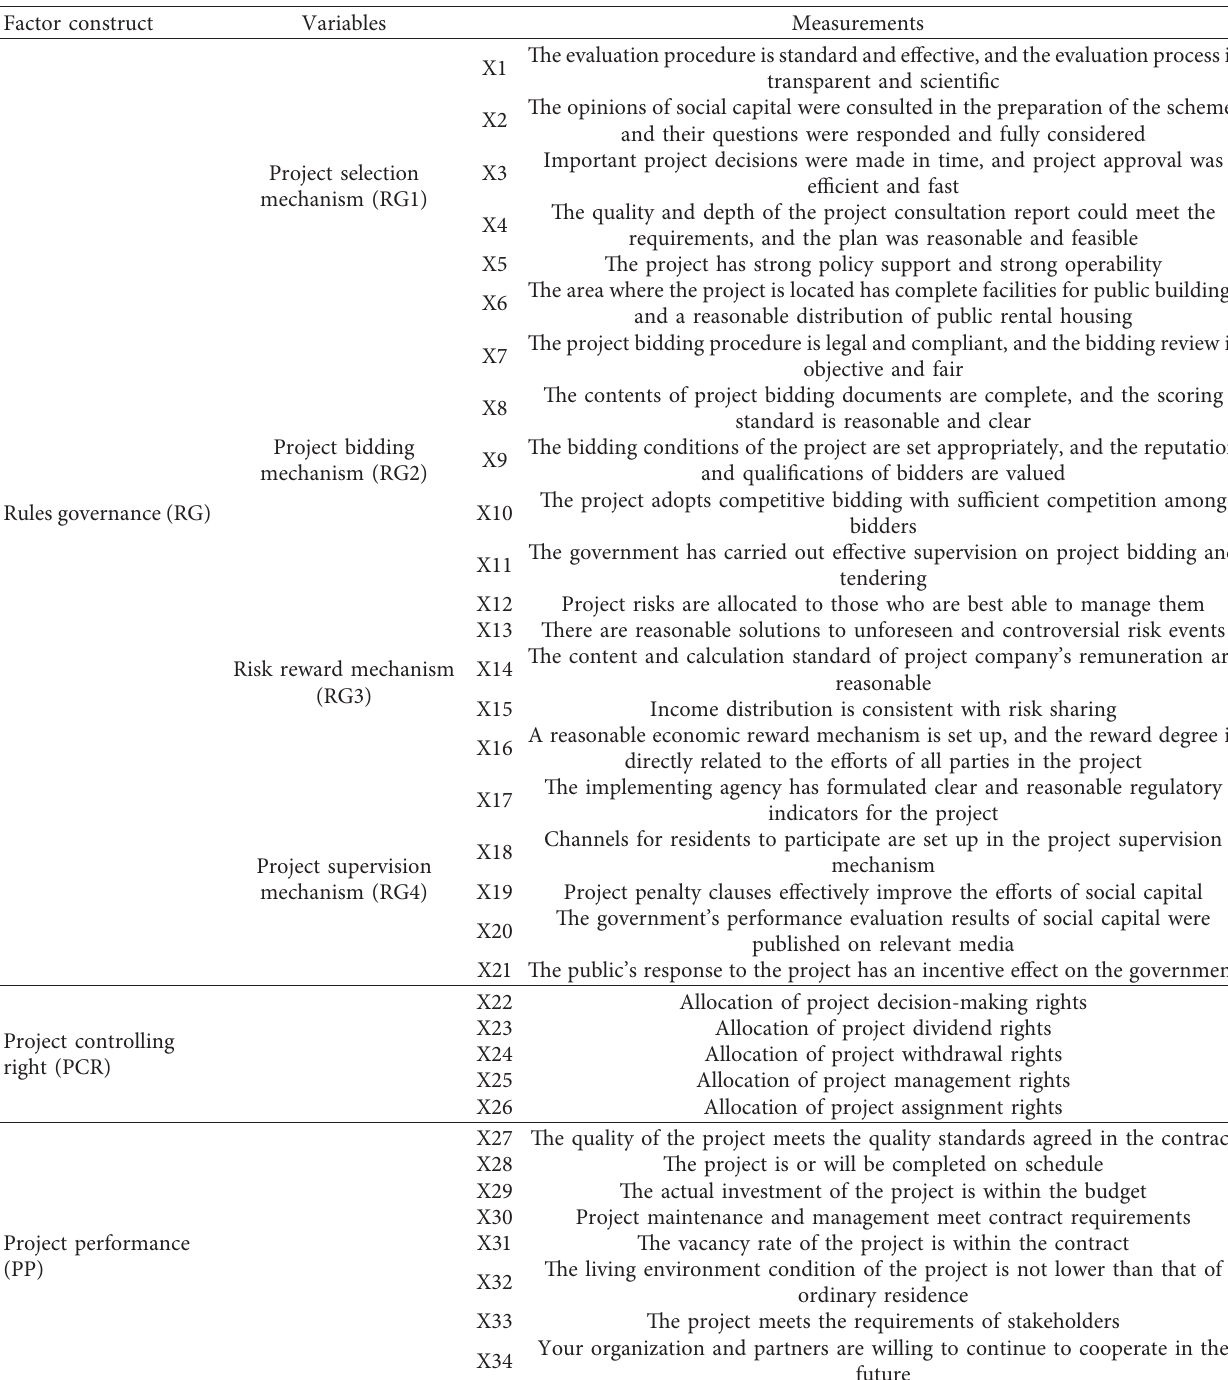
Table 1: Variable measures and questionnaire